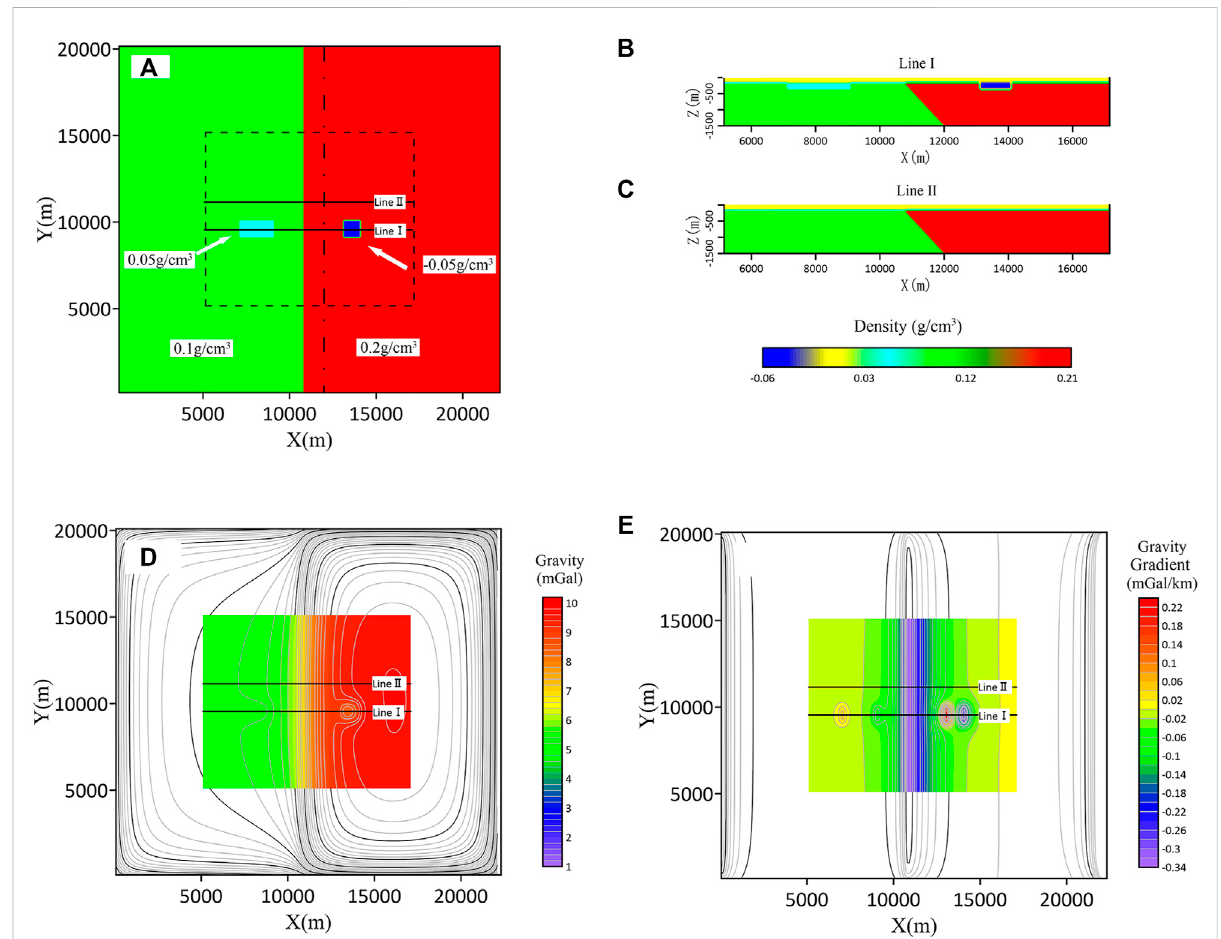
FIGURE 6 Schematic diagram of the reverse fault fracture model. (A) Model z = -200 m plane distribution map. (B) Model line I position pro fi le, (C) Model line II position pro fi le. (D) Forward gravity modeling results of the model. (E) Forward results of the horizontal gradient in the x-direction of gravity in the